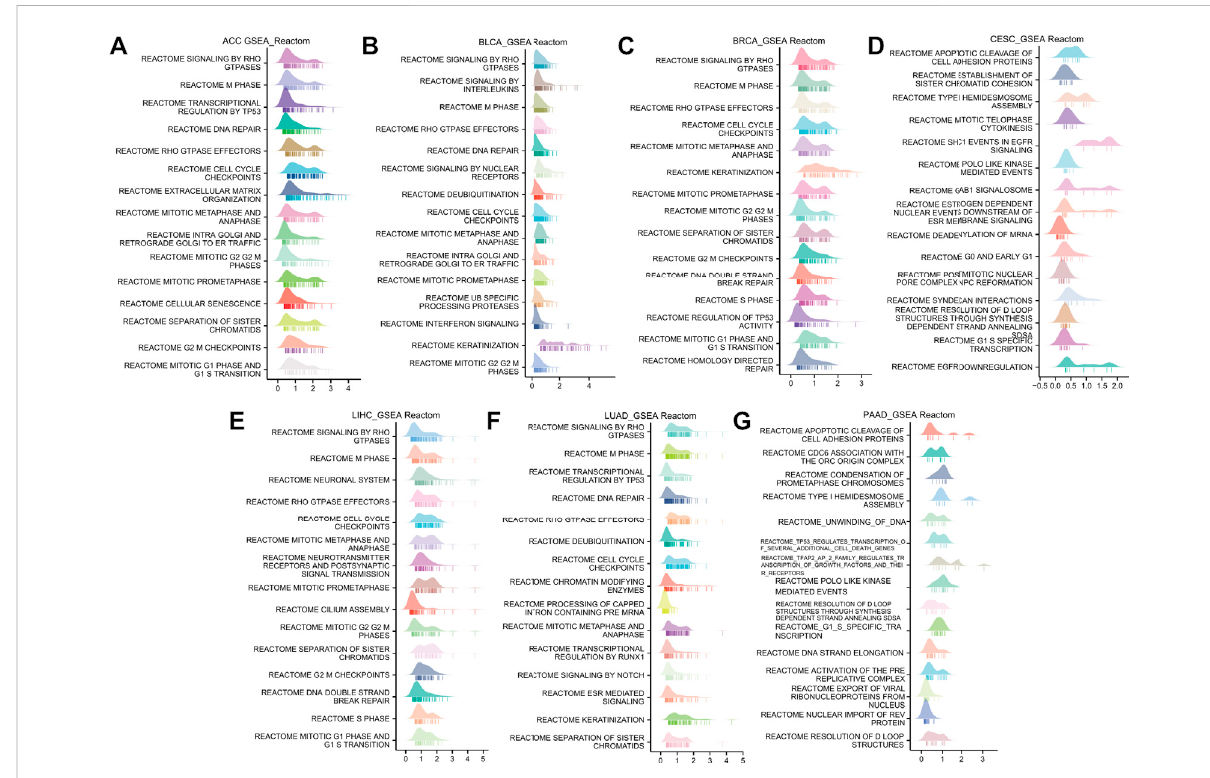
FIGURE 8 GSEA functional enrichment analysis of ANLN in 7 cancers. The top 15 Reactom pathways of ANLN in ACC (A) , BLCA (B) , BRCA (C) , CESC (D) , LIHC (E) ,LUAD (F) ,andPAAD (G) .LogFCvaluesaredistributedaccordingtothenumberofcoremoleculesineachgeneset,andthe Y -axisrepresents each gene